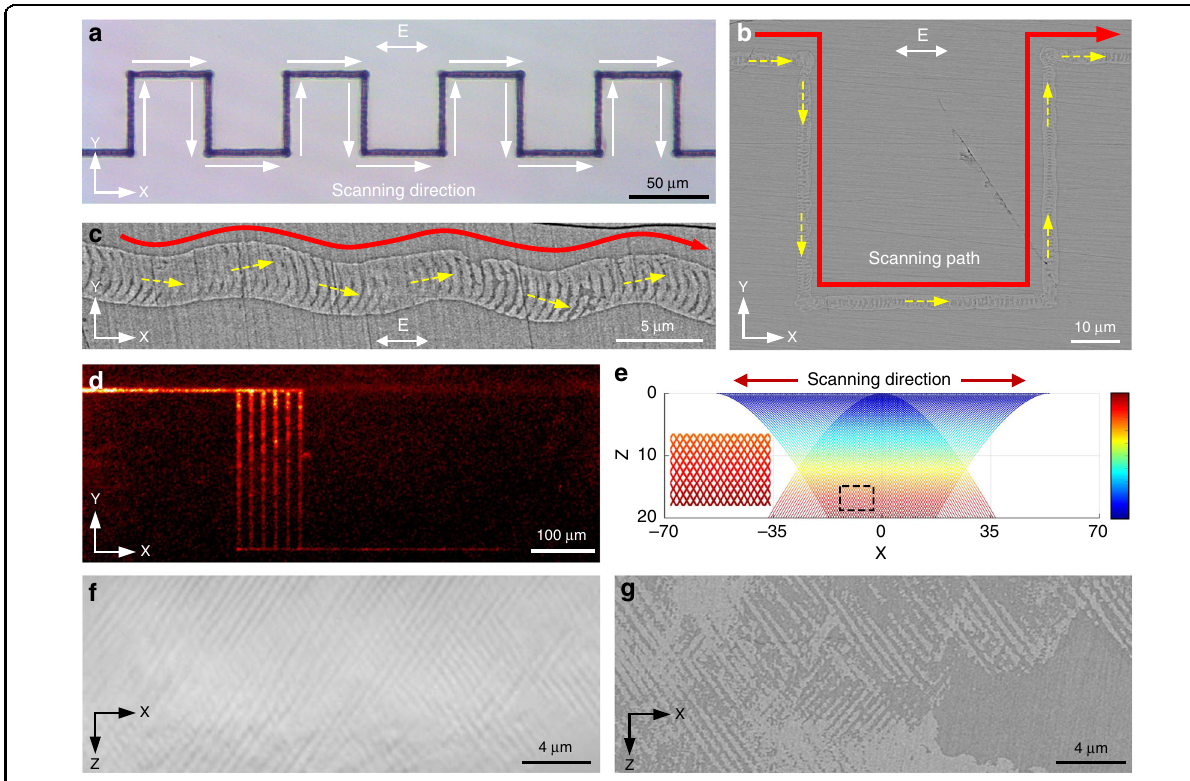
Fig. 5 Demonstration of more complex textures. a Optical image of the line created by the noncontinuous variable-direction writing process. The direction changes 90° each time. b Corresponding SEM image of the textures in the scanning path presented in a , and c shows an SEM image of the textures induced by the continuous variable-direction writing process. The red line indicates the scanning path and the yellow dotted arrow indicates the orientation of the textures. The laser polarization is denoted by E. d Demonstration of waveguides made of the textures using a 980-nm laser. e Theoretical morphology of the interlaced texture predicted by the SOPTL principle. Inset: the ampli fi ed image of the dotted area. The color bar illustrates the radius change of the EPSs. f Optical microscope image of the interlaced textures created by a dual writing process. g SEM image of the interlaced photonic